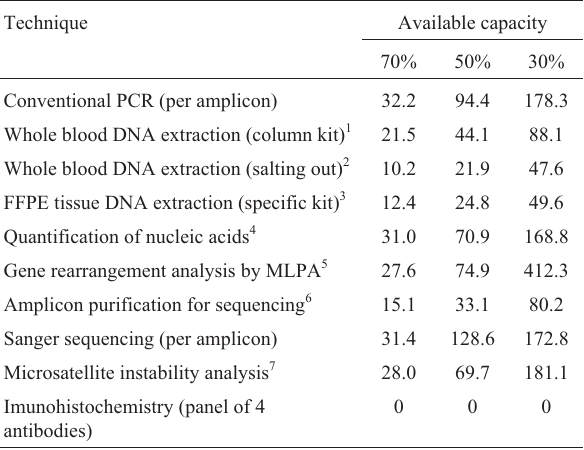
Table 2 - Change in costs (%) according to the use of available